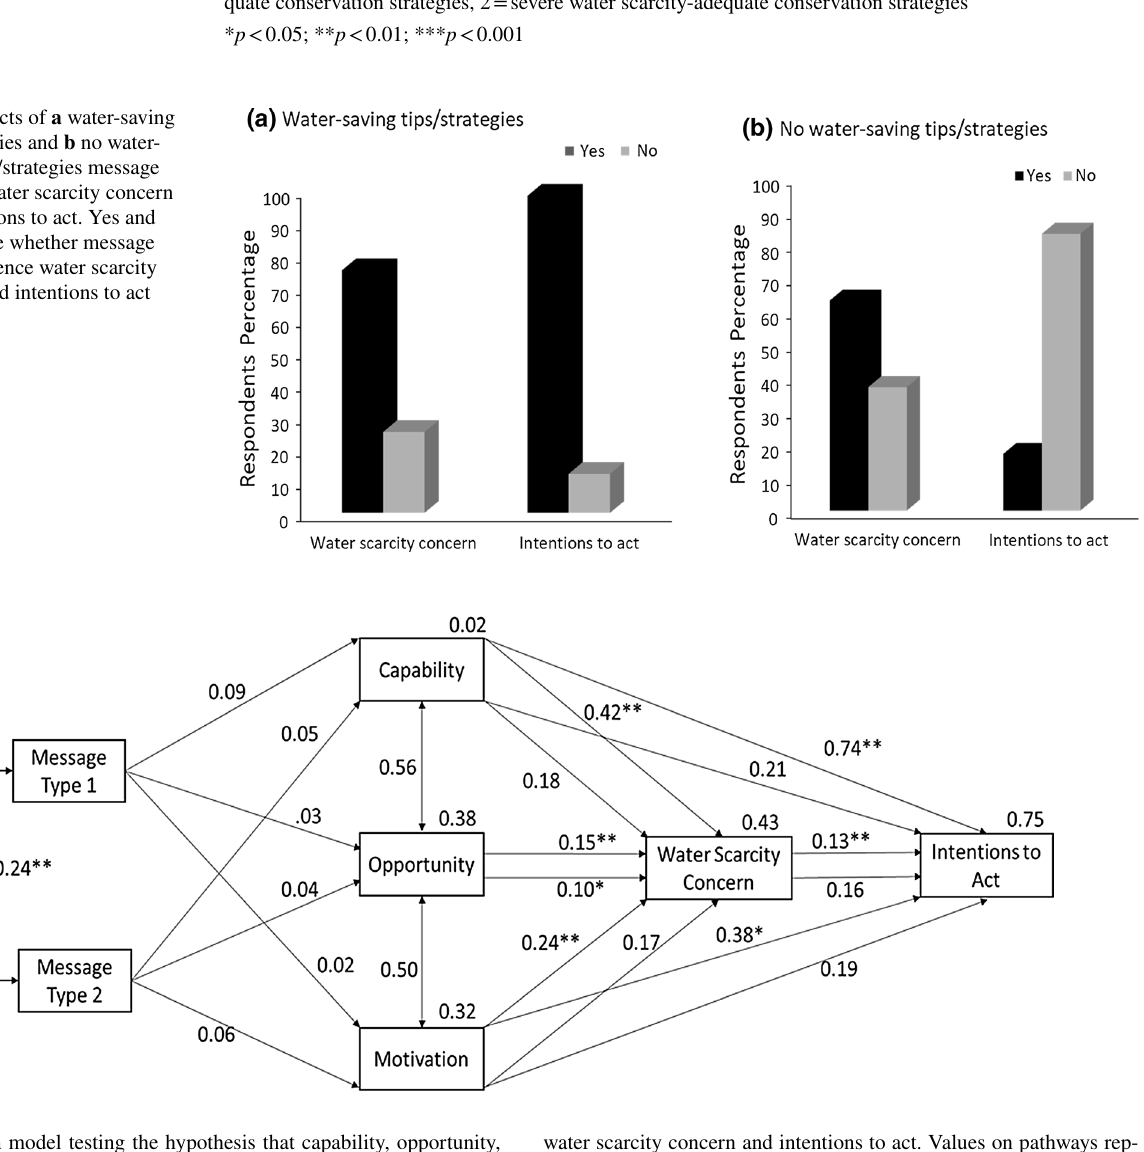
water scarcity concern and intentions to act. Values on pathways rep- resent standardised weights. Model fit indices: χ 2 (4 , N = 510) = 6.80, P = 0.15, GFI = 0.99, CFI = 1.00, RMSEA = 0.04, SRMR =